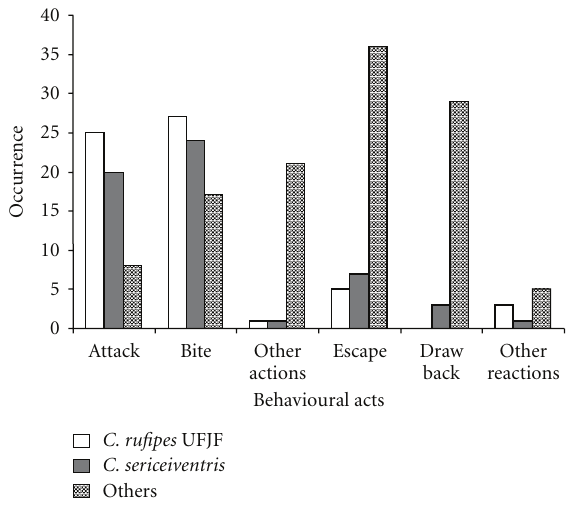
Figure 2: Action and reaction behavioural occurrences for C. rufipes , C. sericeiventris , and other morphospecies (grouped together) during field experiments at the Campus of Federal University of Juiz de Fora. The “other actions” and “other reactions” behaviours are grouped together because of their low frequency.